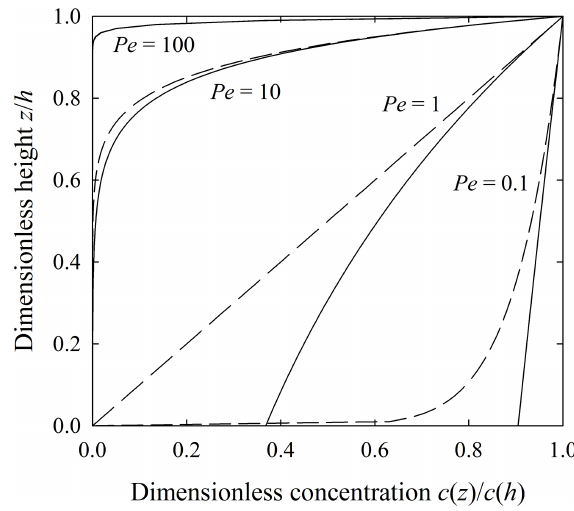
Figure C1. Plot of dimensionless OSL particle concentration ˆ c ( ˆ z ) = c ( z ) /c ( h ) versus dimensionless height ˆ z = z/h with uniform mixing (solid lines) and nonuniform mixing (dashed lines) as these vary with the Péclet number Pe = Wh/K z